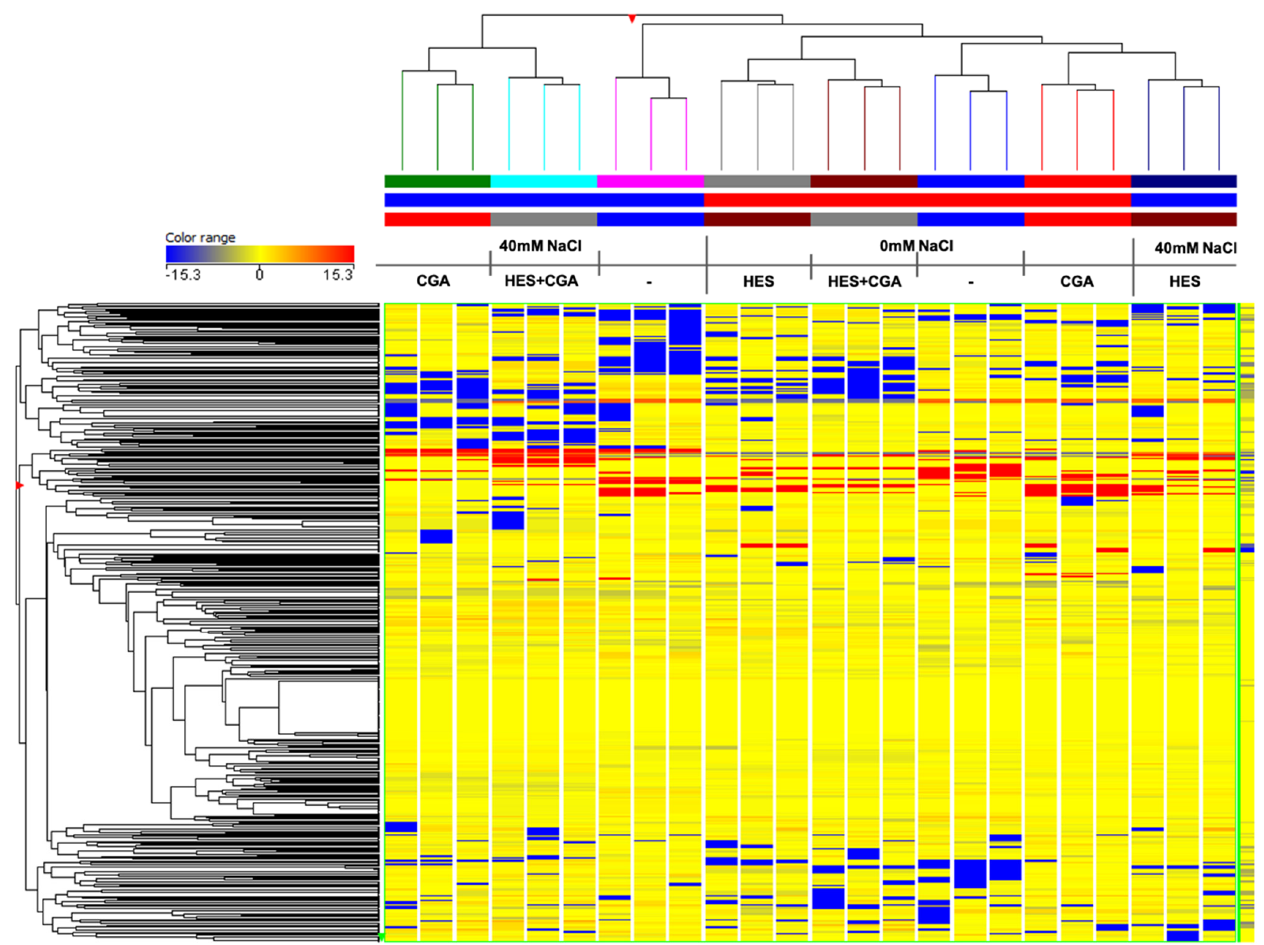
Figure 1. Unsupervised hierarchical clustering analysis (HCA) built using intensity values obtained from UHPLC-QTOF-MS and normalized relative to the median. Lettuces were treated with: 100 µM hesperidin (HES), 50 µM chlorogenic acid (CGA), and 100 µM hesperidin + 50 µM chlorogenic acid (HES + CGA). The treatments were performed both under non-salt (0 mM NaCl) and under salt-stress (40 mM NaCl) conditions.